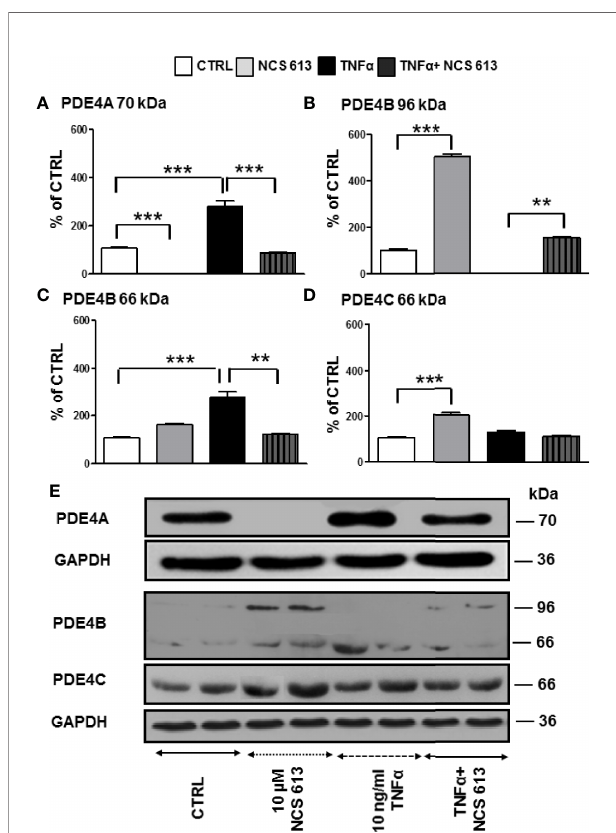
FIGURE 1 | Detection of PDE4A, PDE4B, and PDE4C expressions in control and TNF a -stimulated A549 cells following NCS 613 treatment. A549 cells were stimulated with TNF a to induce in fl ammation and treated with NCS 613 for 48 h under the following experimental conditions: control, +10 m M NCS 613, + 10 ng/ ml TNF a , and +TNF a + NCS 613. Relative protein expression levels were calculated following digitalization and image analysis from 3 independent experiments. (A) NCS 613 prevents and TNF a increases PDE4A 70 kDa overexpression; (B) NCS 613 induces PDE4B 96 kDa expression in A549 cell line; (C) TNF a stimulation induces PDE4B 66 kDa upregulation which is decreased with NCS 613 treatment; (D) PDE4C 66 kDa increases upon NCS 613 treatment; (E) representative immuno-reactive bands revealed by Western blot analysis (n=3). Unpaired Student ’ s t -test. Mean ± SEM. ** p < 0.01 and *** p <